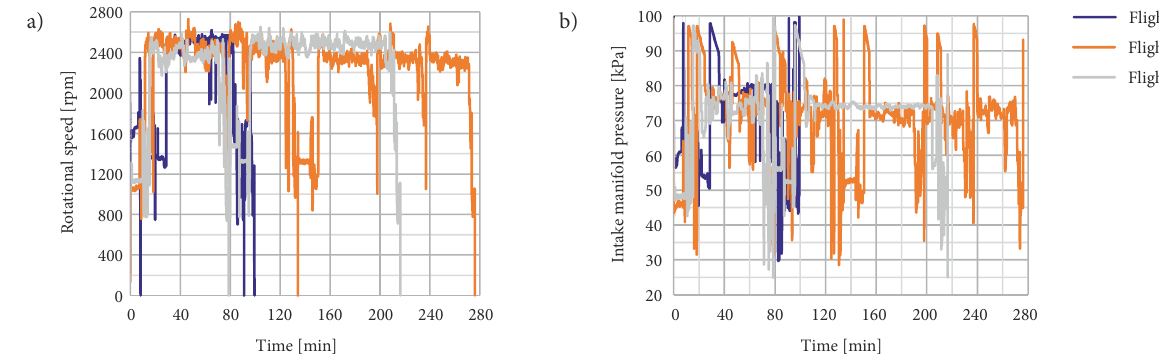
Figure 3. Engine rotational speed (a) and intake manifold pressure (b) for the Liberty XL2 flights